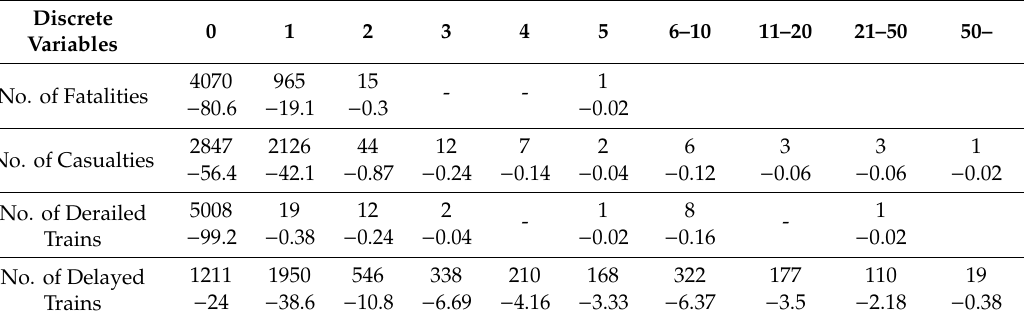
Table 3. Contingency Table for Categorized Discrete Variables.